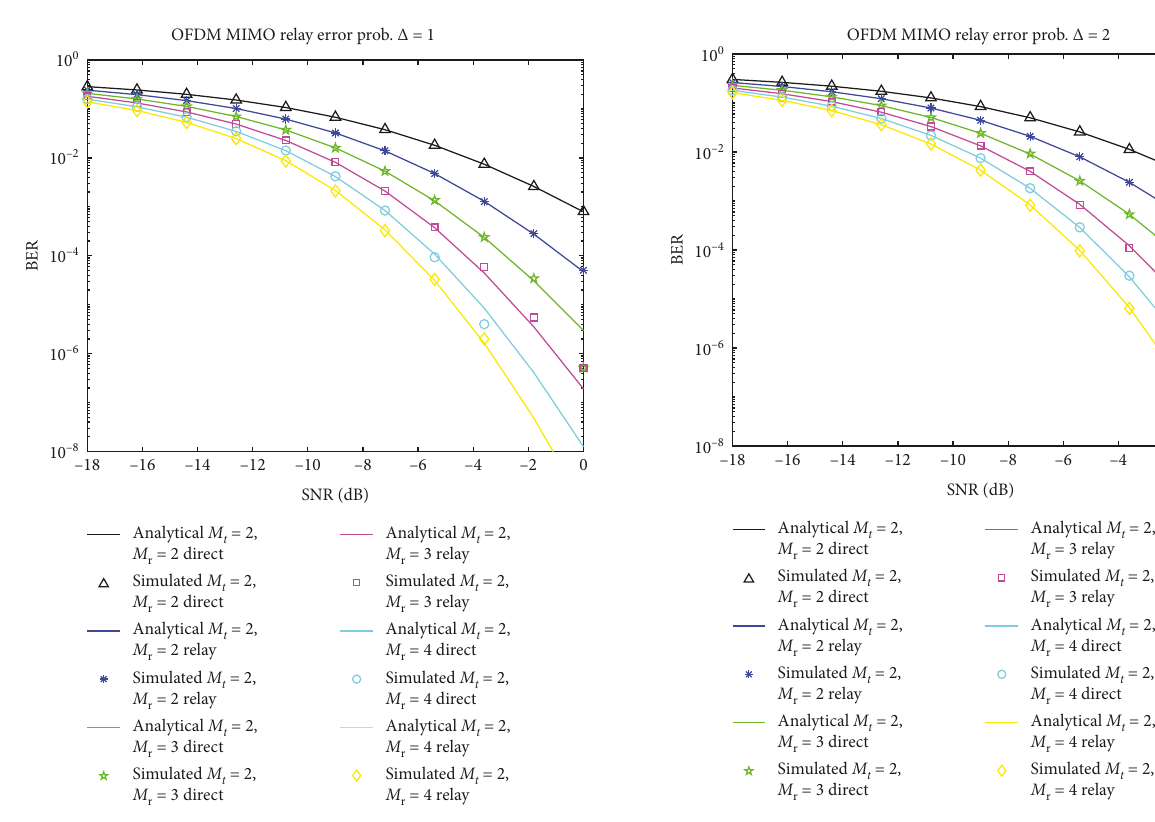
Figure 7: BER performance with MIMO-OFDM direct and relay ( Δ � 1).